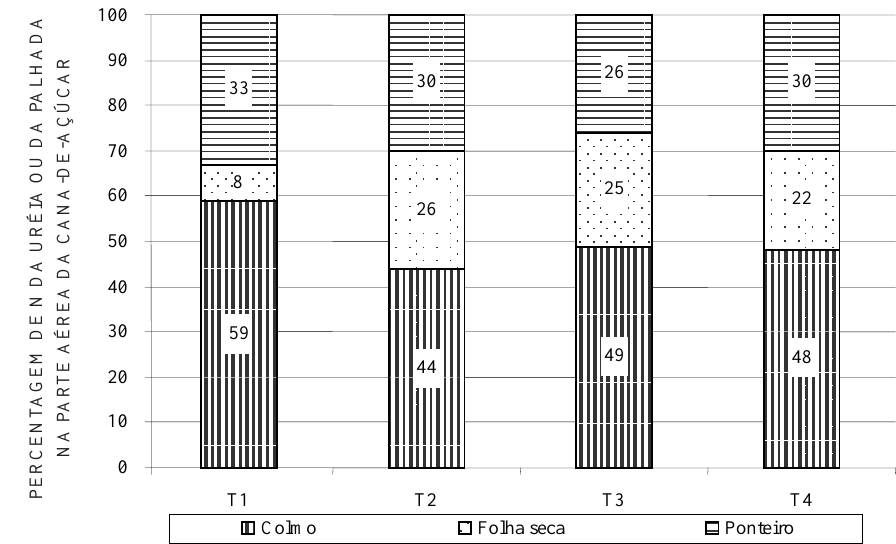
Figura 2. Distribuição percentual do N da palhada e da uréia, em diferentes partes da planta, nos tratamentos T1 (mistura de vinhaça e uréia, com palhada- 15 N); T2 (mistura de vinhaça e uréia- 15 N, com palhada); T3 (mistura de vinhaça e uréia- 15 N, sem palhada) e T4 (uréia- 15 N enterrada com prévia aplicação de vinhaça, sem